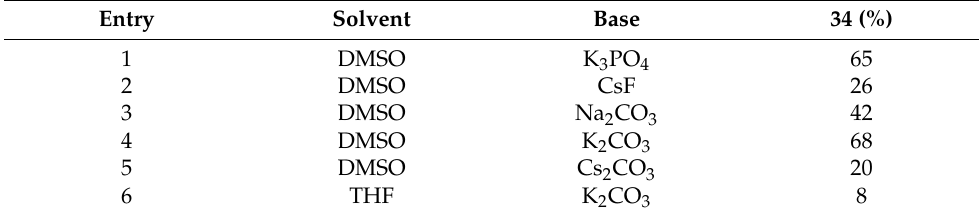
Table 2. Reaction conditions for Sonogashira coupling.